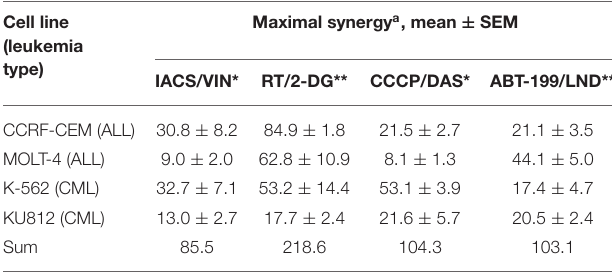
a Based on three independent biological replicates. * Combinations that have been tested for toxicity against normal blood cells at doses corresponding to CML treatment (maximal synergy cutoff > 10 in both CML cell lines). ** Combinations that have been tested for toxicity against normal blood cells at doses corresponding to both ALL and CML treatment (maximal synergy cutoff > 10 in both ALL/CML cell lines).